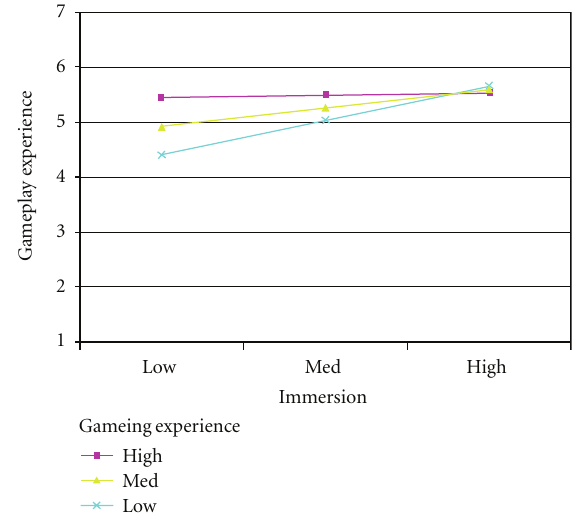
Figure 4: Interaction between immersion and gaming experience on gameplay experience.